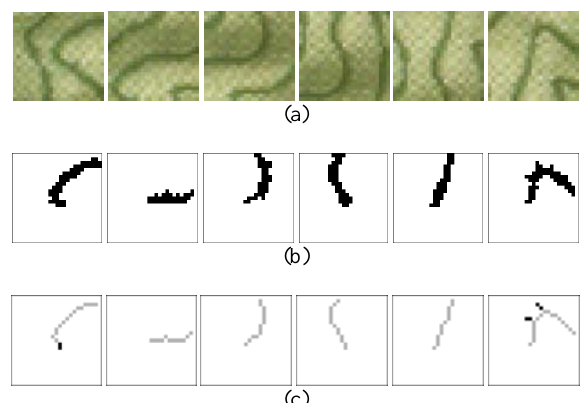
Figure 9. Sequential line tracking. a Continuous sliding window. b The result of line tracking